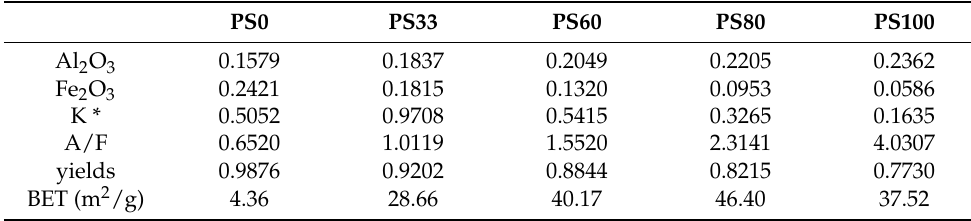
Figure 4. TC removal capacity by PS80 and PS0 with and without H 2 O 2. Table 3. Chemical Composition and Firing Behavior of red mud-steel slag-sludge.